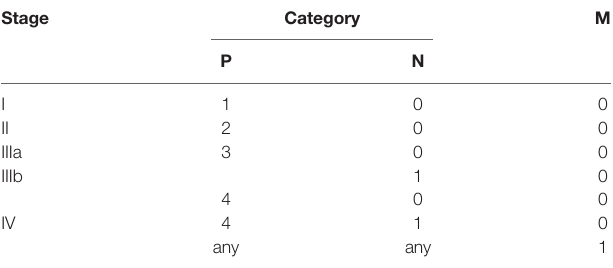
TABLE 2 | The patient ’ s PNM stage grouping of alveolar